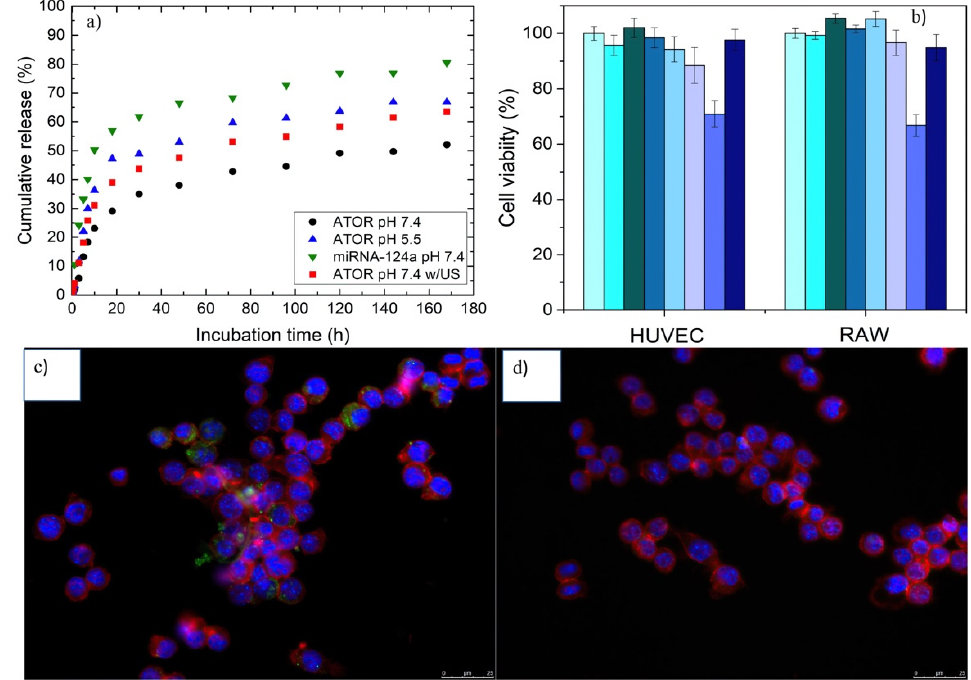
Figure 2. ( a ) Release profiles of ATOR at ( • ) pH 7.4, ( (cid:4) ) pH 5.5, ( (cid:78) ) miRNA at pH 7.4, and ( (cid:72) ) ATOR release at pH 7.4 in the presence of applied ultrasounds from NPs. Error bars are not shown for clarity (uncertainties < 10%, three different replicates); ( b ) cell viability of HUVEC and RAW cells in the presence of polymeric NPs after 24 h of incubation. (From left to right) control LPS- activated cells, 5.0 × 10 9 , 1.0 × 10 10 , 2.5 × 10 10 , 5.0 × 10 10 , and 1.0 × 10 11 NPs/mL of ATOR-loaded PLGA/miRNA NPs, free ATOR, and free miRNA. Internalization of ( c ) fluorescently labeled, ATOR- loaded PLGA/scramble miRNA NPs (5 × 10 10 NPs/mL), and ( d ) free, fluorescently labeled, scramble miRNA in RAW 264.7 macrophages. Scale is 25 mm.